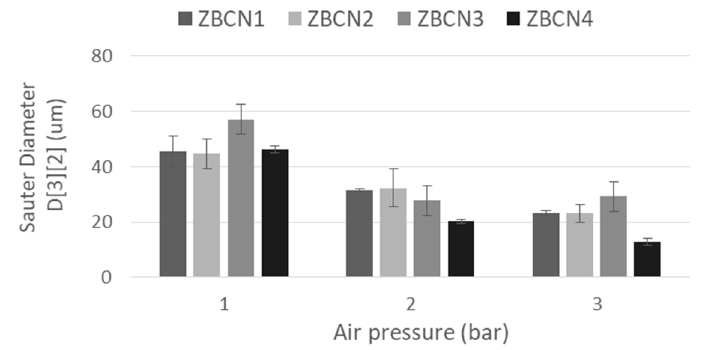
Figure 5. Dependence between the volume-surface diameter and air pressure.